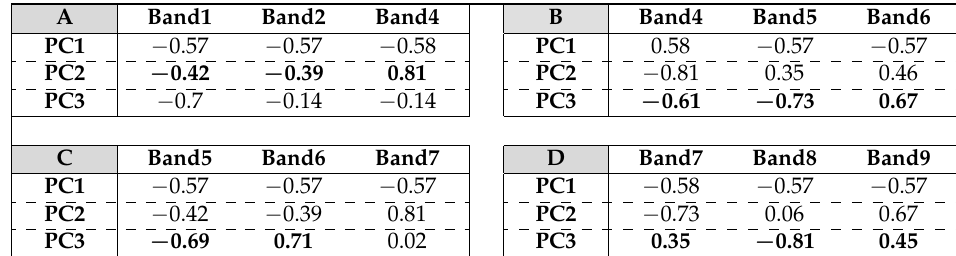
Table 1. Eigenvector loadings matrix calculated using Selective Principal Component Analysis (SPCA) for selected Advanced Spaceborne Thermal Emission and Reflection Radiometer (ASTER) bands. ( A )